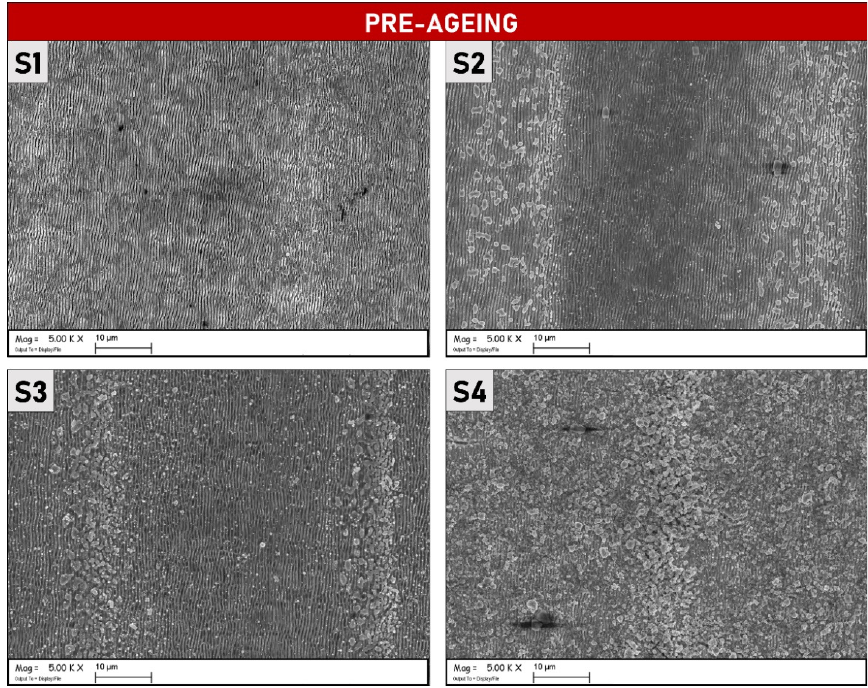
Figure 2. SEM micrographs (magnification 5 k×) of the four different Molybdenum samples (( S1 ), ( S2 ), ( S3 ) and ( S4 ), experimental parameters relative to the labels are reported in Table 1) after laser irradiation.